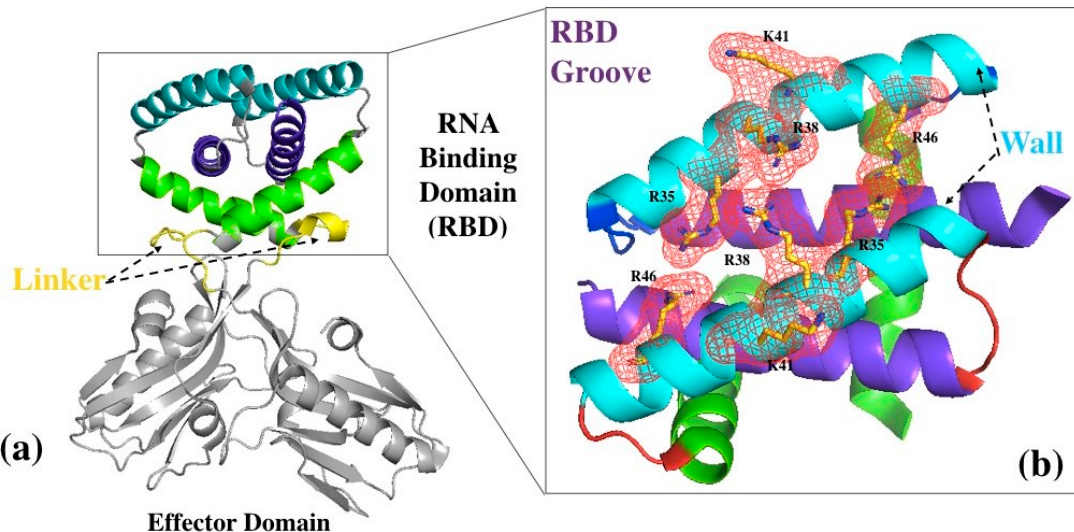
Figure 1. Crystal structure of the full-length protein. ( a ) Ribbon representation of the dimeric full-length protein with its two domains (Protein Data Bank (PDB) access number 4OPA): the RNA-binding domain dimer (framed in black) comprises six symmetry-related α -helices ( α 1 and α 1 (cid:48) in deep blue, α 2 and α 2 (cid:48) in cyan, α 3 and α 3 (cid:48) in green). The two domains are connected by a linker (yellow) ( b ) zoom-in on the RNA-binding domain and its groove, viewed from the top with respect to orientation in ( a ); the antiparallel α 2-helices (cyan, residues 30–50) form the walls of the groove, while helices α 1 and α 1’ (deep blue, residues 3–24) form its bottom. Helices α 3 and α 3’ (green, residues 54–70) connect the RNA-Binding Domain (RBD) to the E ff ector domain via the linker. Residues R35, R38, R46 and K41 from the α 2 helices are represented in mesh